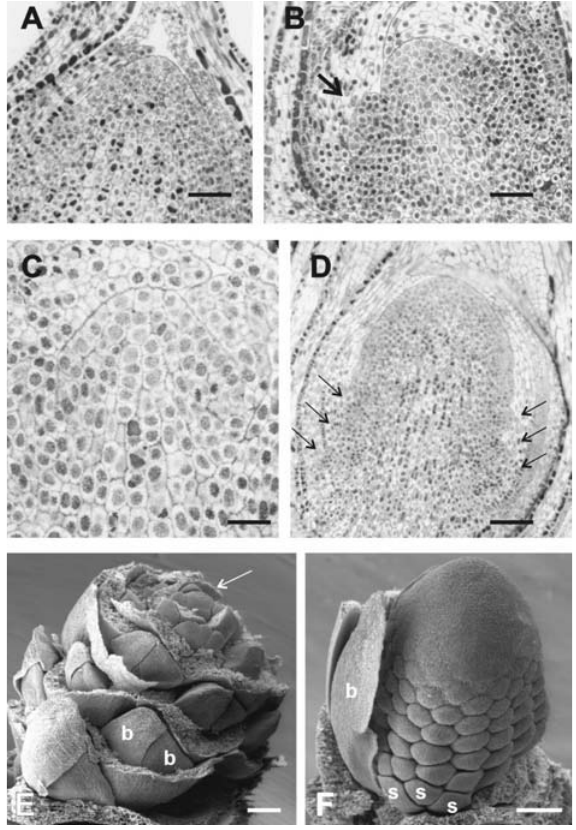
Figure 1 - P. caribaea var. caribaea vegetative and reproductive meristem development. A-D: Toluidine blue-stained longitudinal sec- tions.EandF:SEM.Apicalvegetativemeristemofajuvenile(1year-old) plant. B: Apical meristem of an adult (15 year-old) plant. The arrow indi- cates a lateral meristem. C: Early-developing female cone. The oviliferousscaleprimordialstillnotvisible.D:Developingfemaleconeat the onset of the oviliferous scales (arrows) E: Long-shoot apex of an adult (15 year-old) plant. The arrow points to the terminal meristem. Bracts (b) coverandprotectthesubordinatebranchlateralmeristems.F:Developing female cone at the onset of the oviliferous scales, at approximately the same stage as that shown in D. b: bract primordium s: oviliferous scale primordium. Bars: A and B: 150 µ m; C: 100 µ m; D and F: 200 µ